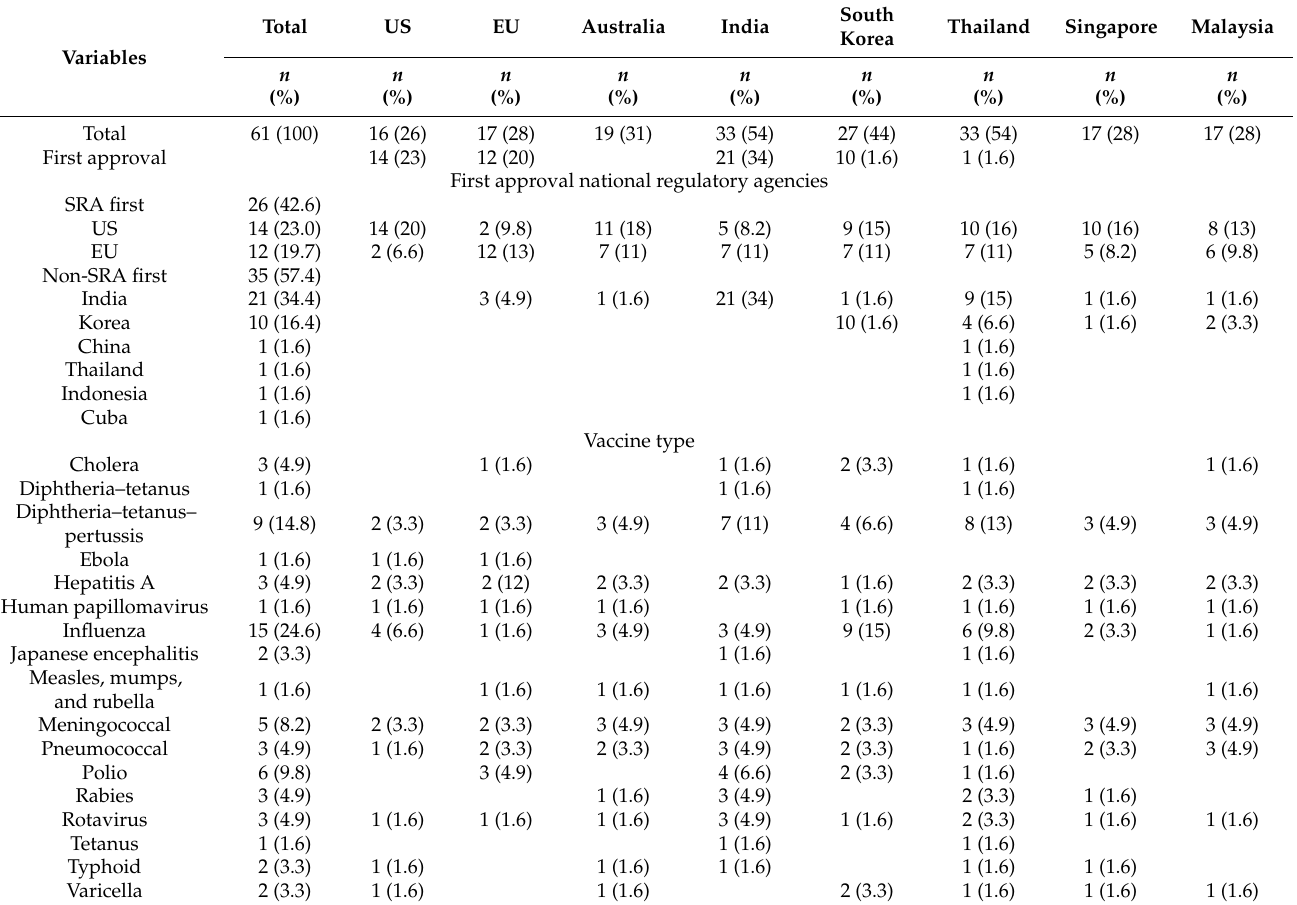
Table 3. Absolute approval lag of WHO-prequalified vaccine by first approval country and vaccine type ( n =